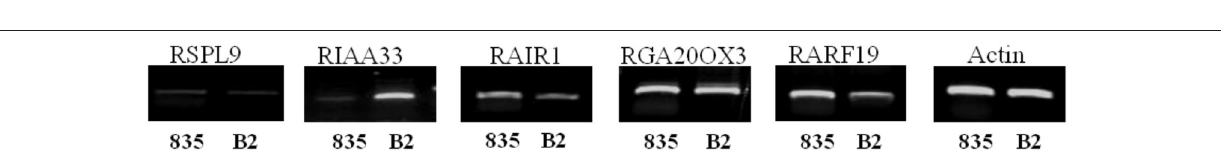
FIGURE 3 | Semi-quantitative RT-PCR analysis of candidate genes using RNA samples extracted from 20-day-old seedlings of “835” and “B2.” Actin gene amplicons were used as control for RNA quantity.